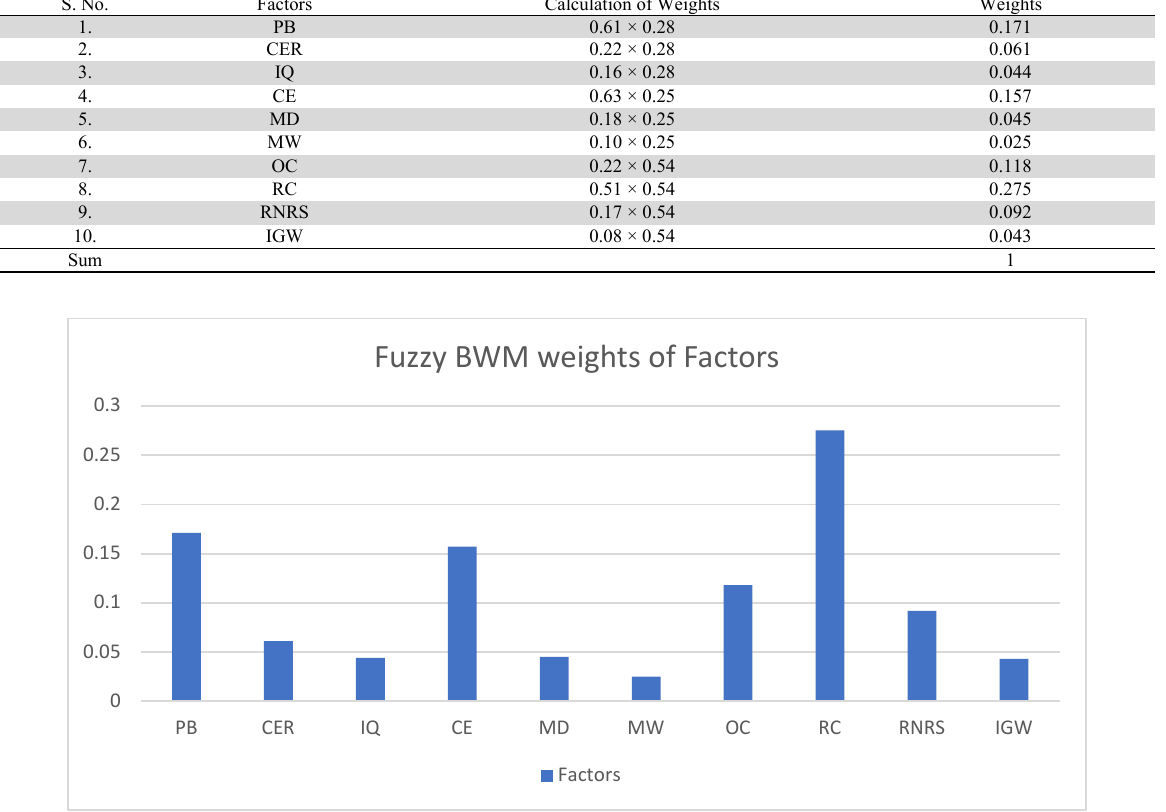
Fig. 3. Weight of all criteria by Fuzzy Best-Worst method